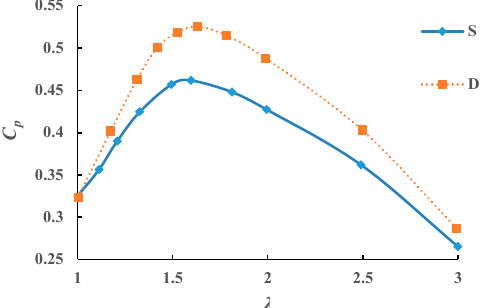
Figure 12. Comparison of power output efficient with different lambda between stand-alone turbine and twin-rotors turbine.